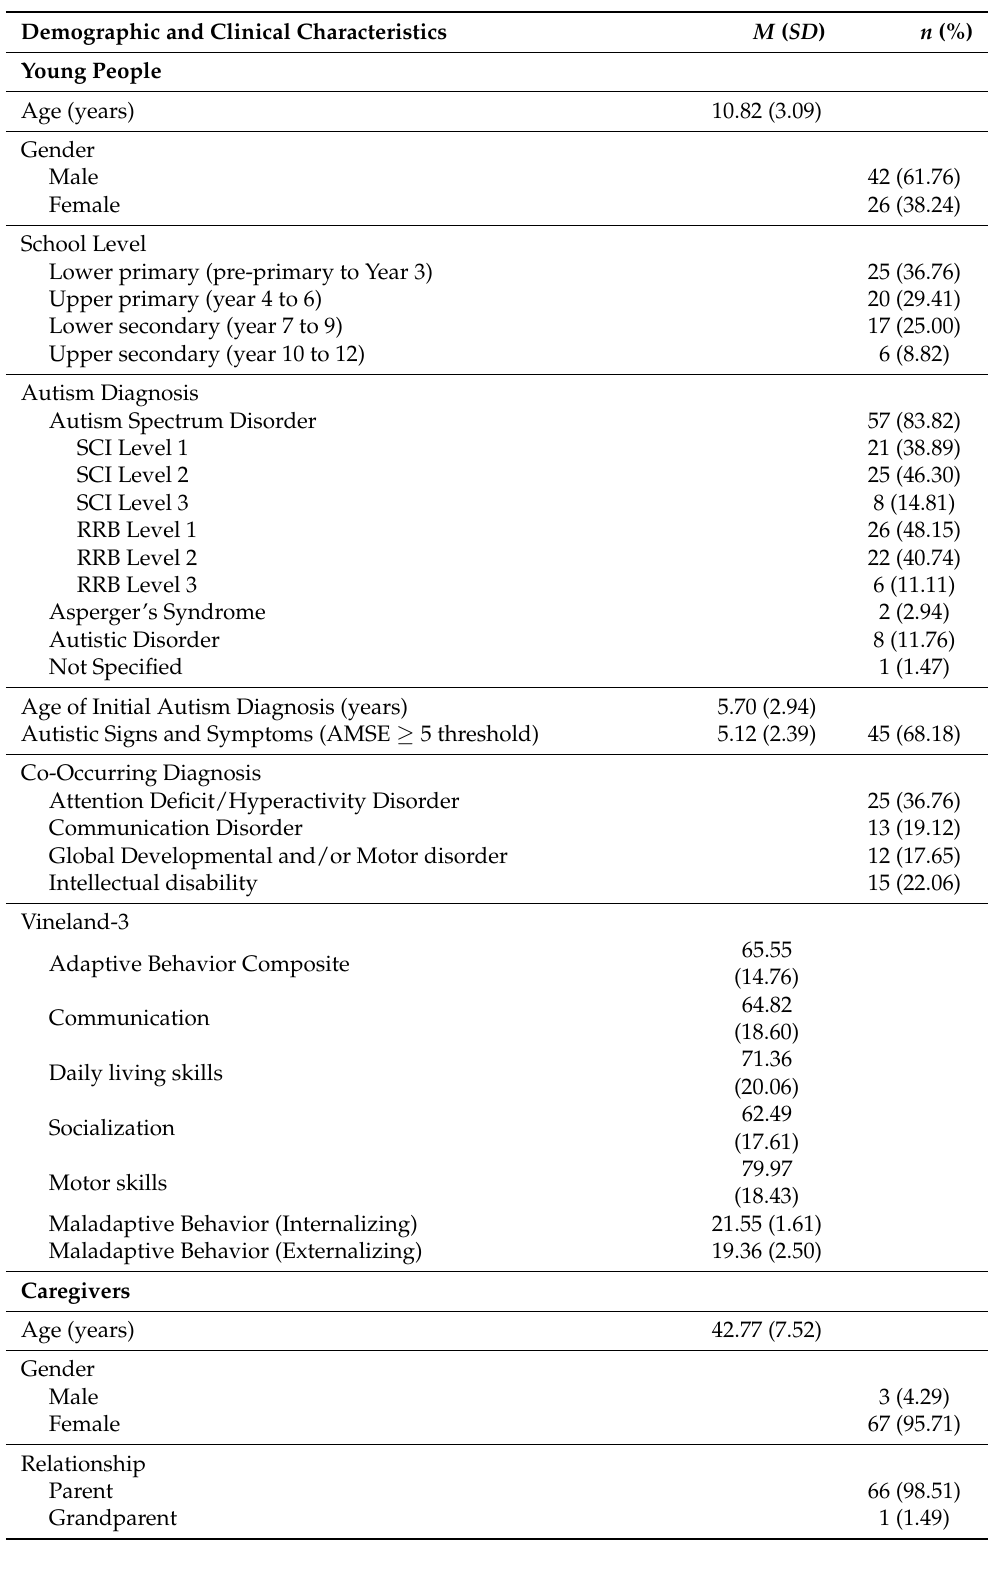
Table 1. Description of the demographic and clinical characteristics of the young people ( n = 68) and caregivers ( n = 70), families and supports, reported as mean ( M ) and standard deviation ( SD ) or frequency ( n and